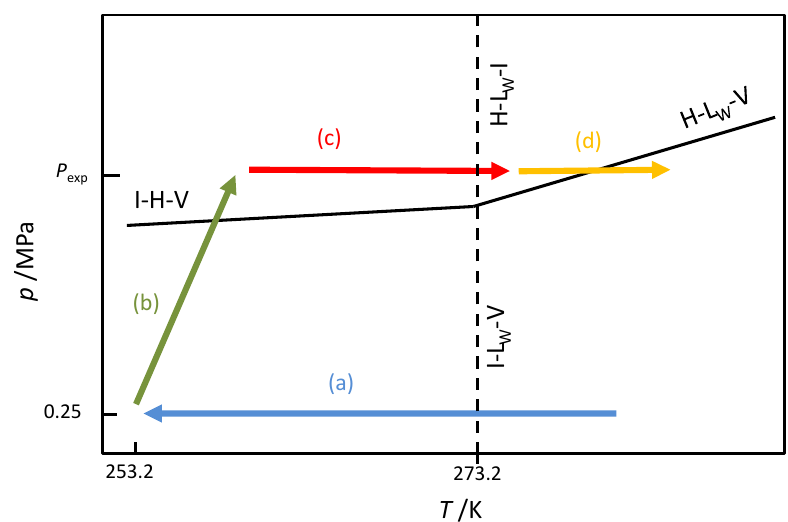
Figure 1. Pre-treatment of the water droplet. ( a ) Ice formation at constant pressure. ( b ) Pressure is increased to the experimental pressure. ( c ) Hydrate formation from ice. ( d ) Hydrate